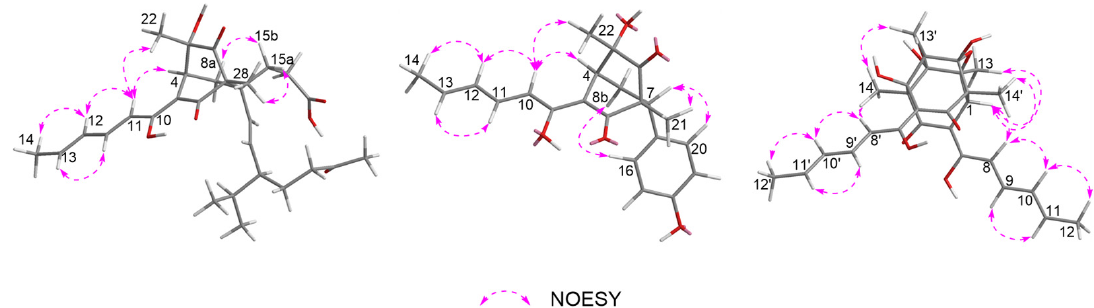
Figure 3. Key NOESY correlations of compounds 1 – 3 .